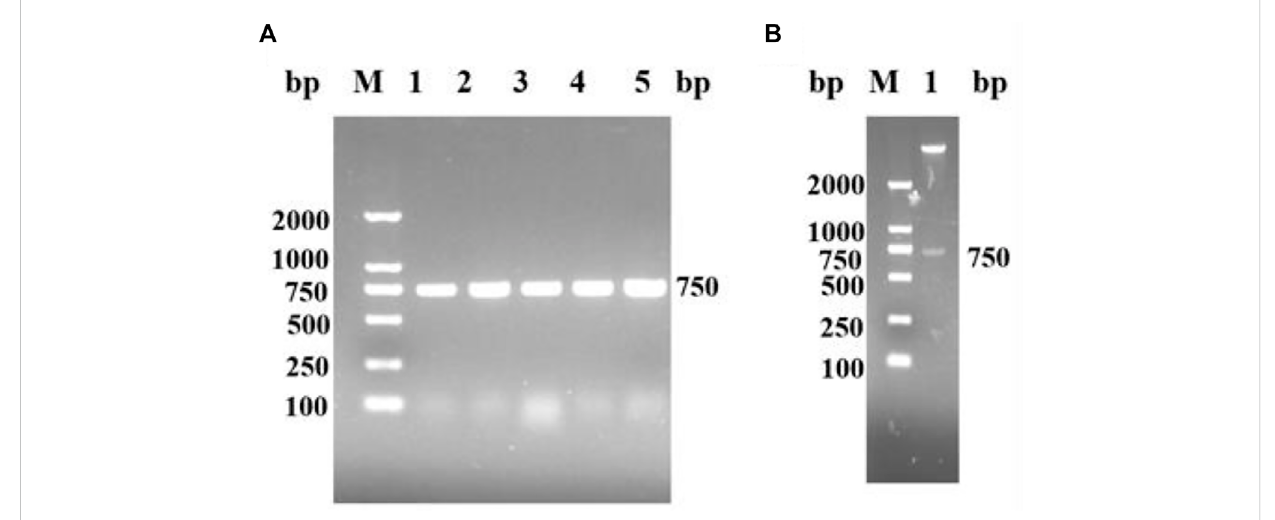
FIGURE 1 The agarose gel electrophoresis analysis for PCR products of Sc NRK1. and double enzyme digestion veri fi cation of recombinant E. coli BL21 (DE3)/ pET28a- Sc NRK1. (A) PCRdetection.LaneM,DNAmarker;lane1-5,PCRproductsfromdifferentstrainsof E.coli BL21(DE3)/pET28a- Sc NRK1; (B) Double digestion detection. Lane M, DNA marker; lane 1, Double digestion products of E. coli BL21 (DE3)/pET28a- Sc NRK1 by Nde Ⅰ and Xh o Ⅰ